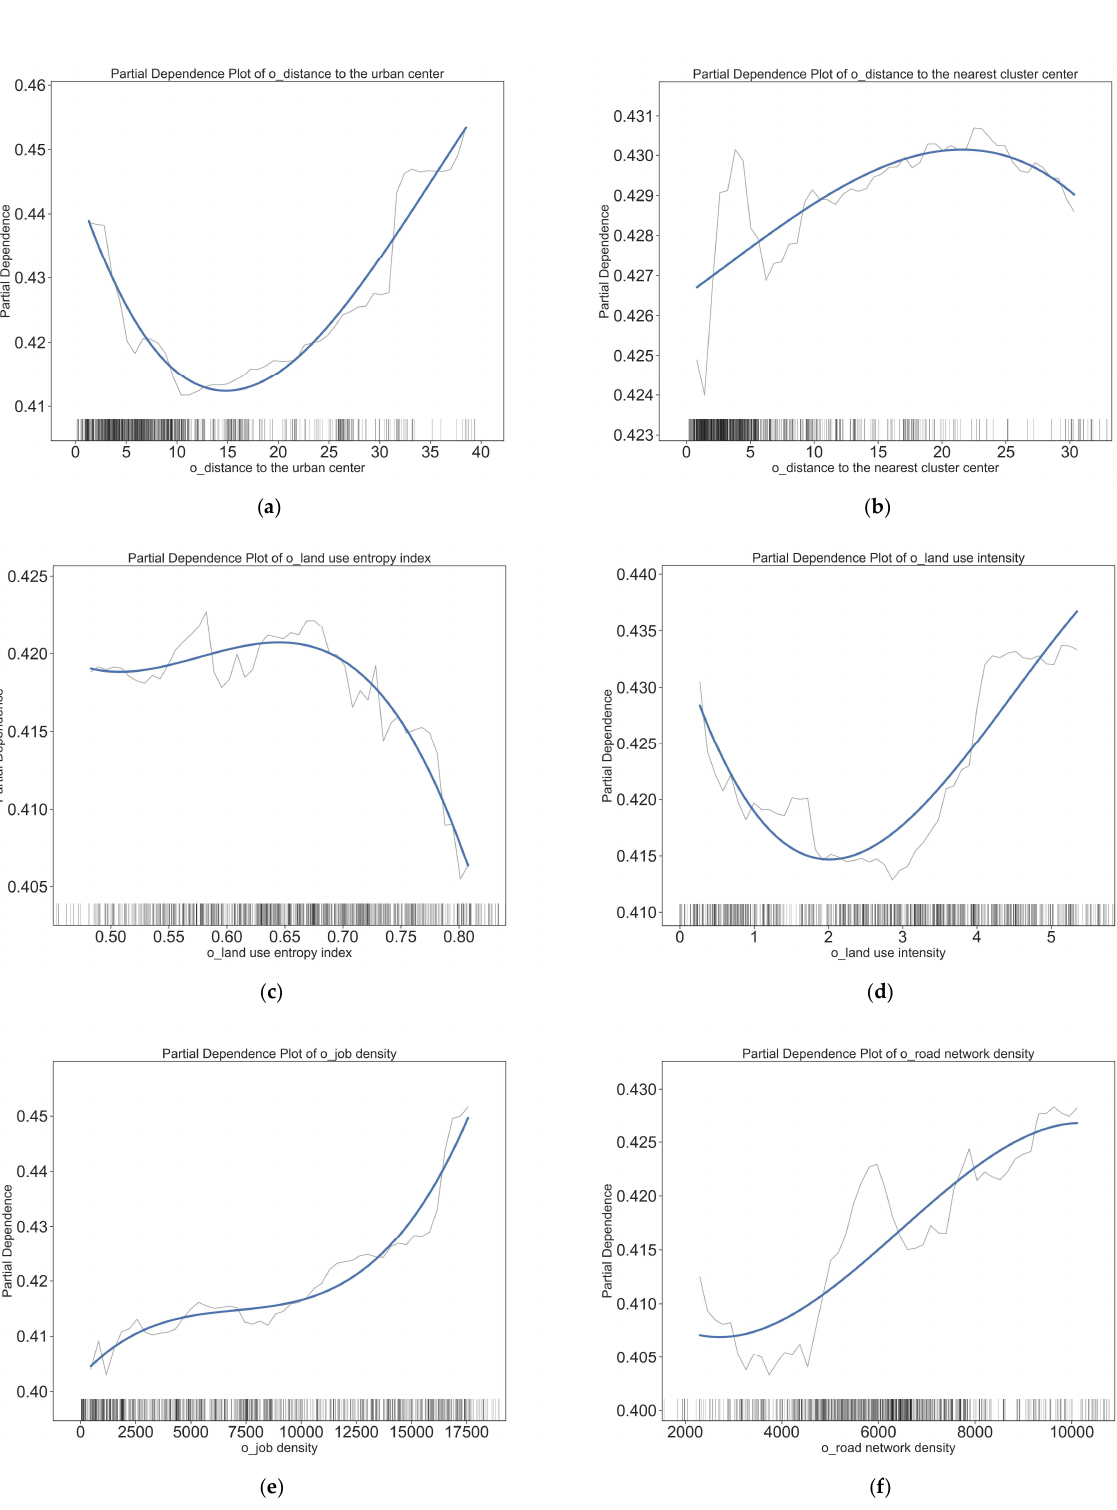
Figure 4. The effects of residential (O point) built environment variables on the choice to walk. ( a ) Impact of distance to the urban center on walking choices; ( b ) impact of distance to the nearest cluster center on walking choices; ( c ) impact of land use entropy index on walking choices; ( d ) impact of land use intensity on walking choices; ( e ) impact of job density on walking choices; ( f ) impact of road network density on walking choices.